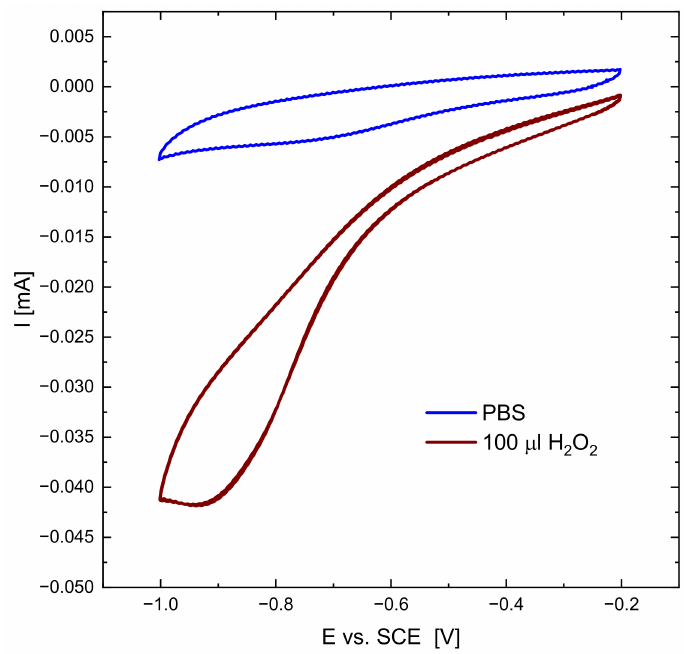
Figure 15. Cyclic voltammetry measurement within the potential range from − 0.2 V to − 1 V vs. SCE in a 0.1 M PBS solution with and without the addition of 100 µ L H2O2. The scan speed was 20